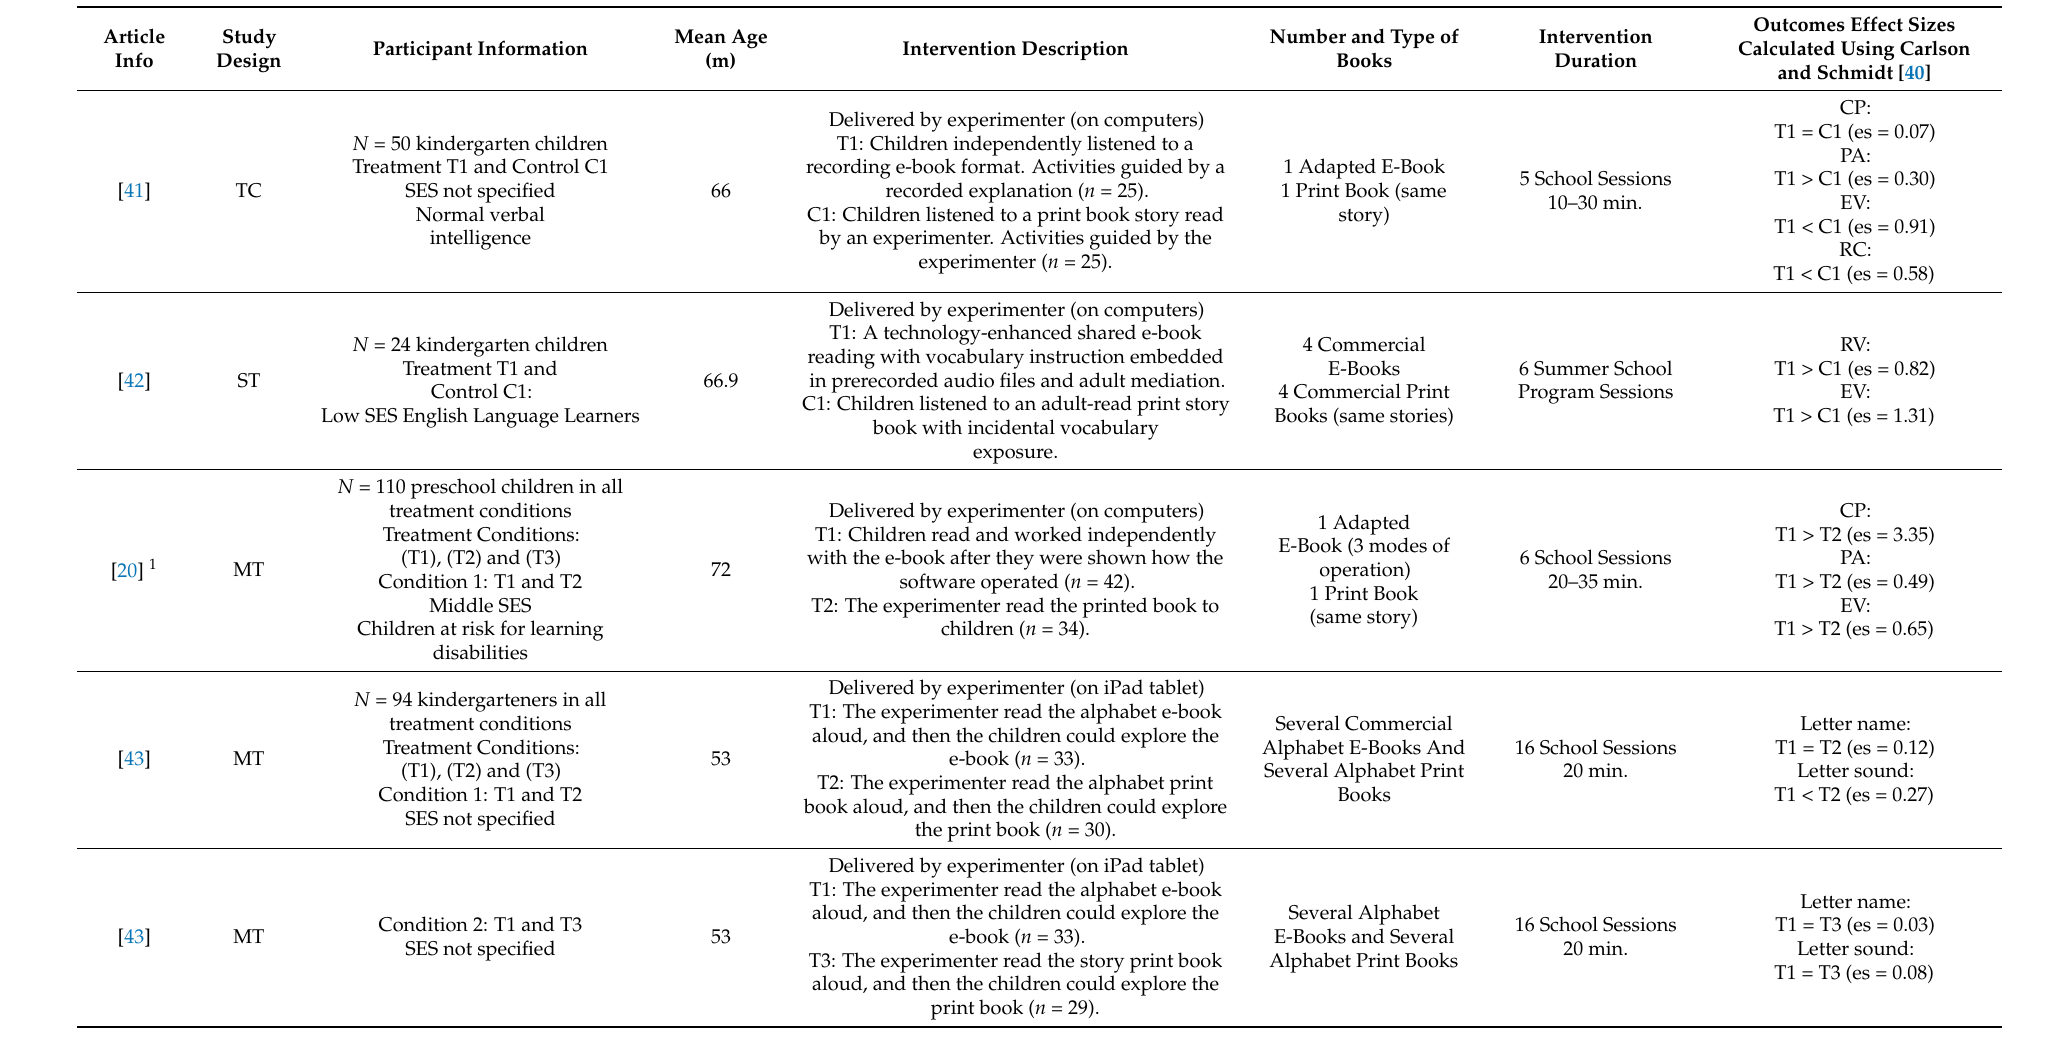
Table 1. Study information (e-book versus print